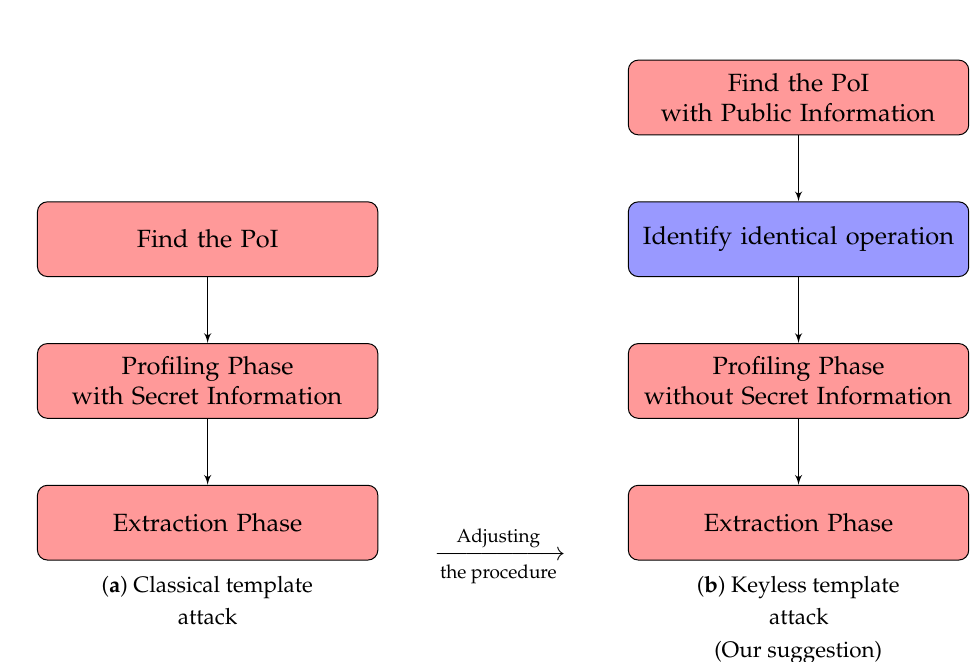
Figure 1. Procedure of classical and keyless template